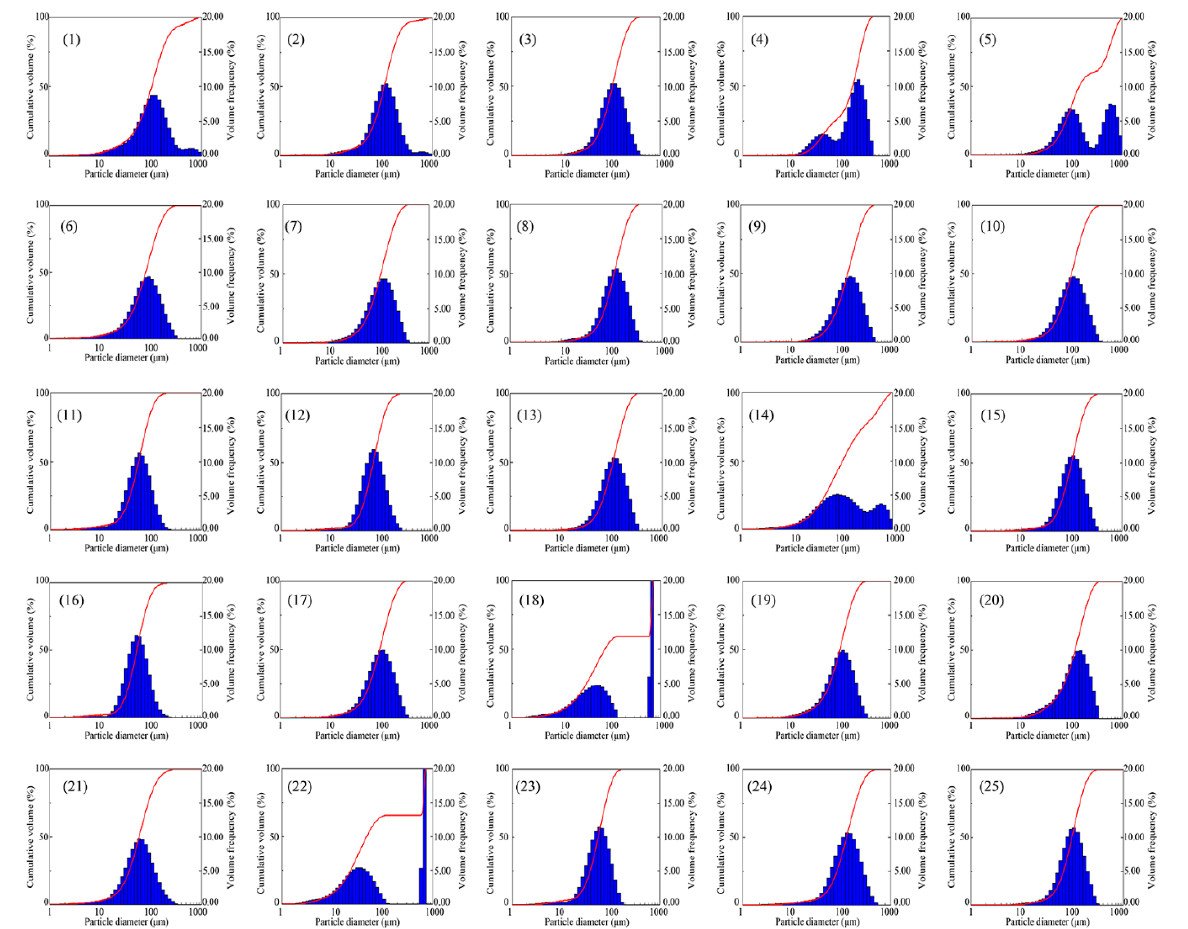
Figure 3. The droplet size distribution under 25 operating conditions.